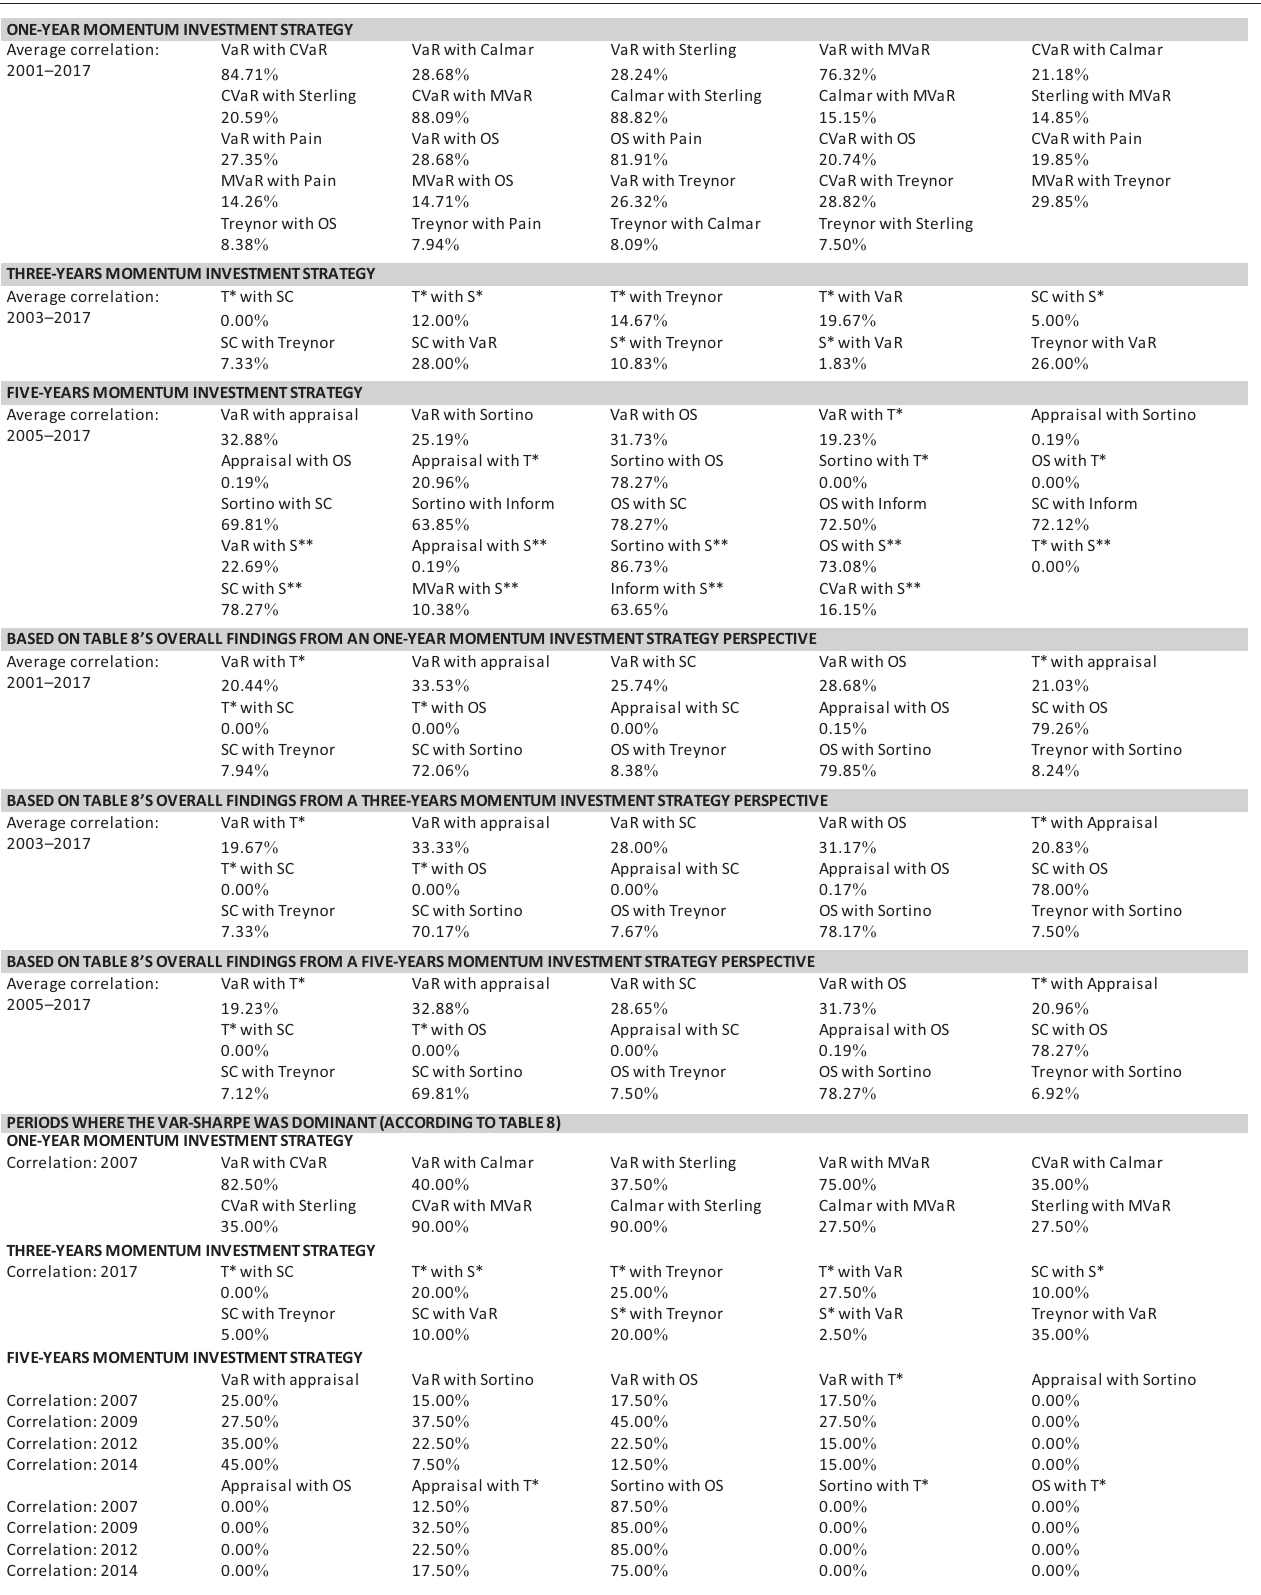
FIGURE 1: Summary of portfolio